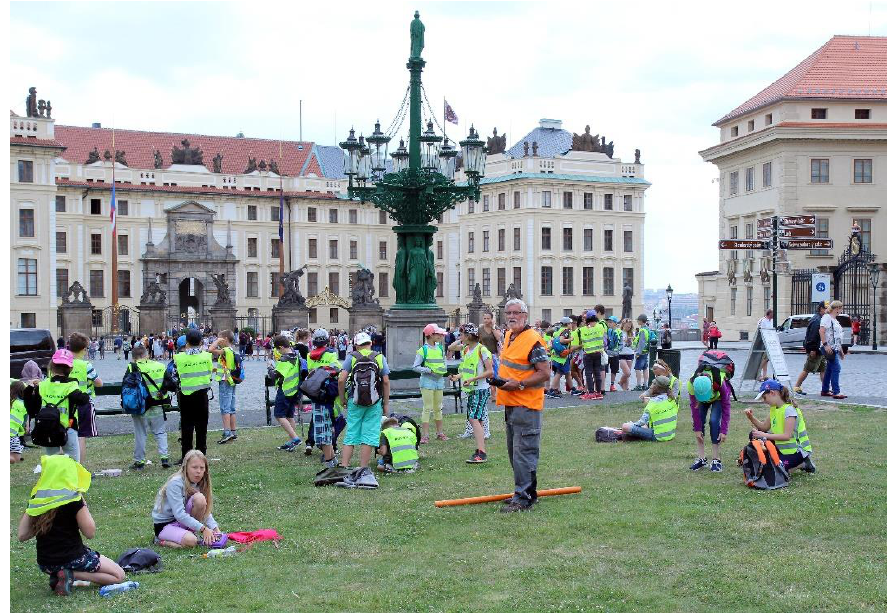
Figure 5. The Hradčany Square. In the foreground is our geophysicist with the CMD-MiniExplorer Figure 5. TheHradˇcanySquare. instrument.